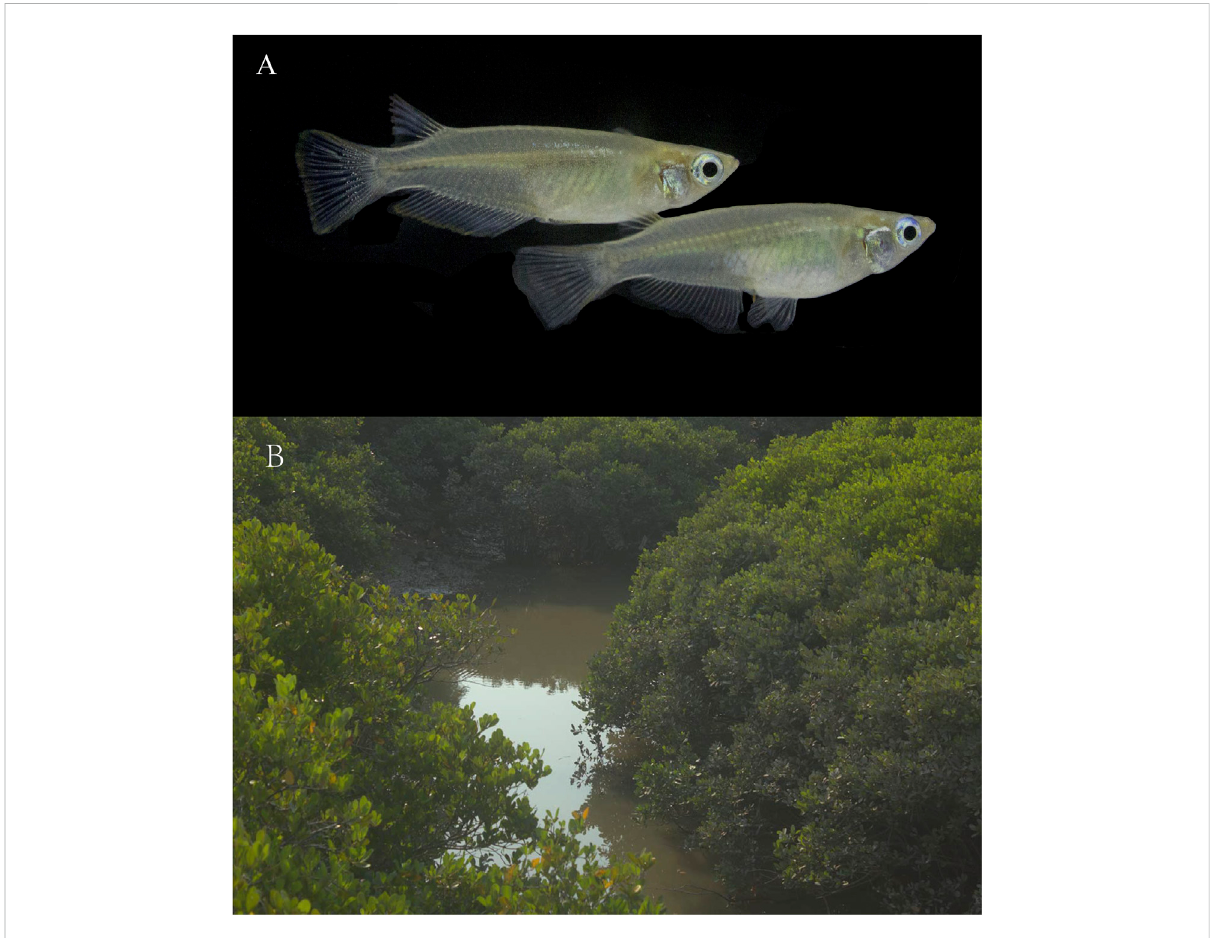
FIGURE 1 Oryzias curvinotus . (A) Male (upper) and female (lower) Oryzias curvinotus form Sanya. (B) Natural habitat of Hainan